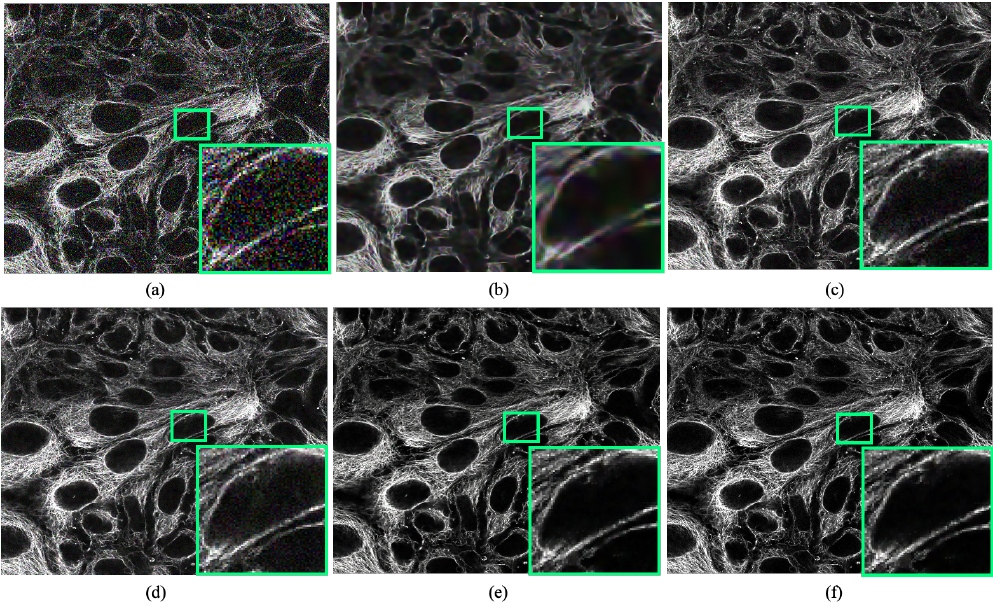
Figure 6. Qualitative comparison of microscopy image denoising at σ = 50. The proposed method illustrates significant improvement over the existing denoising method by improving perceptual image quality. ( a ) Noisy input. ( b ) Result obtained by BM3D [11]. ( c ) Result obtained by DnCNN [16]. ( d ) Result obtained by Residual MID [12]. ( e ) Result obtained by DRAN (proposed). ( f ) Reference sharp image. Source by: